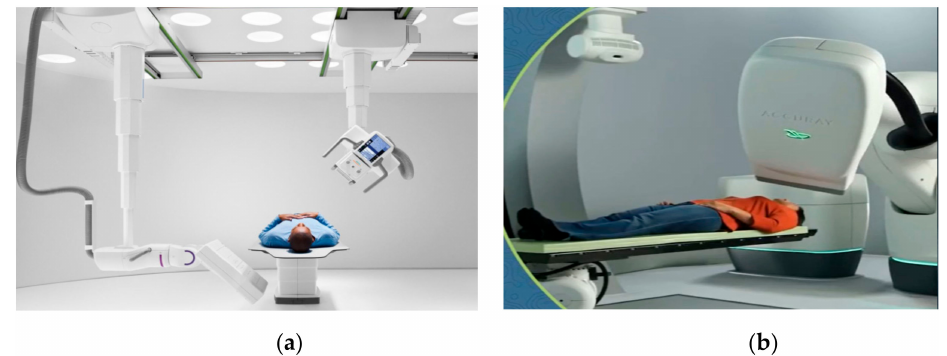
Figure 14. Specialized robots for spine and cranial biopsy and surgery. ( a ) Multitom Rax: Twin Robotic X-ray from Siemens Healthineers [65]. ( b ) Cyberknife: Radiology Oncology Surgical robot [66].